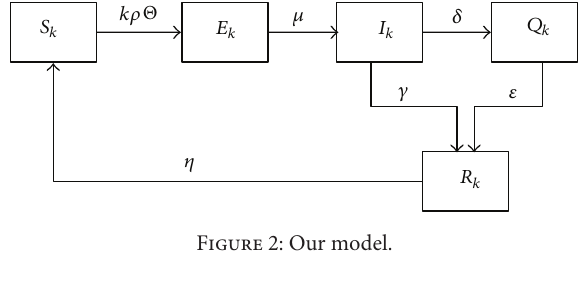
Figure 1: Original model. Figure 2: Our